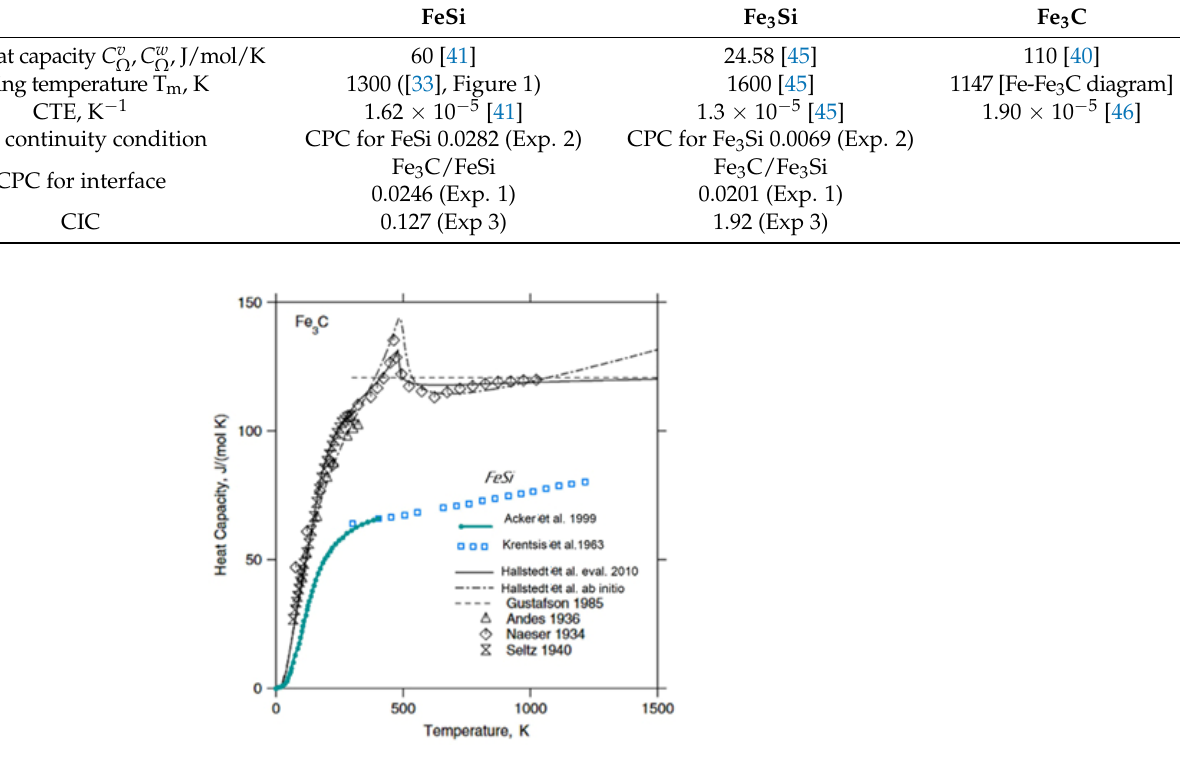
Figure 12. Heat capacity (C p ) of Fe 3 C (reconstructed from [40]) and FeSi [41]. The solid line is calculated using the present thermodynamic description. The dash ‐ dotted line shows the present theoretical ab initio ‐ based calculation. The dashed line is from the thermodynamic description of Gustafson [42]. The symbols are from experimental measurements [43,44]. Table 7. Calculations of the CPC and CIC parameters in the area of the Fe 3 C/FeSi and Fe 3 C/Fe 3 Si phase interface.